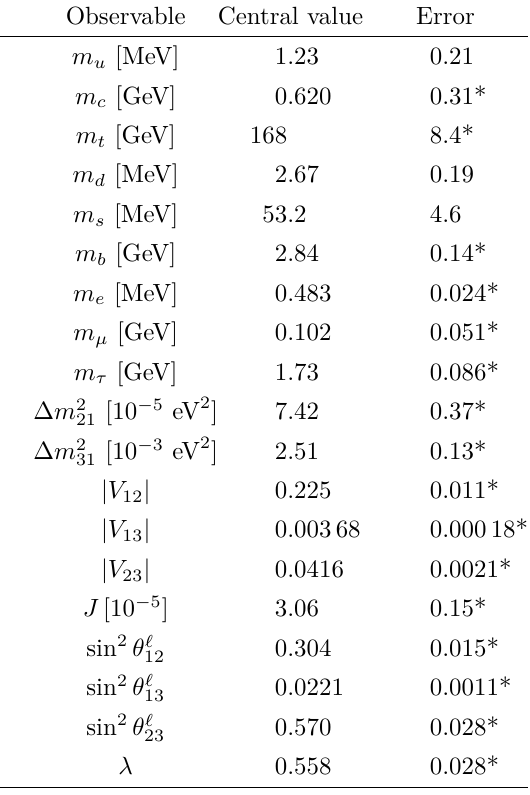
Table 2 . Data for the SM observables at M Z and their corresponding errors used in the fits. Quark masses, charged lepton masses, and Higgs quartic coupling are adopted from ref. [73], neutrino masses and leptonic mixing angles from the July 2020 version of NuFIT [74], and CKM parameters from the Summer 2019 version of CKMFitter [75]. An asterisk denotes an error that has been enlarged to 5 % of the corresponding central